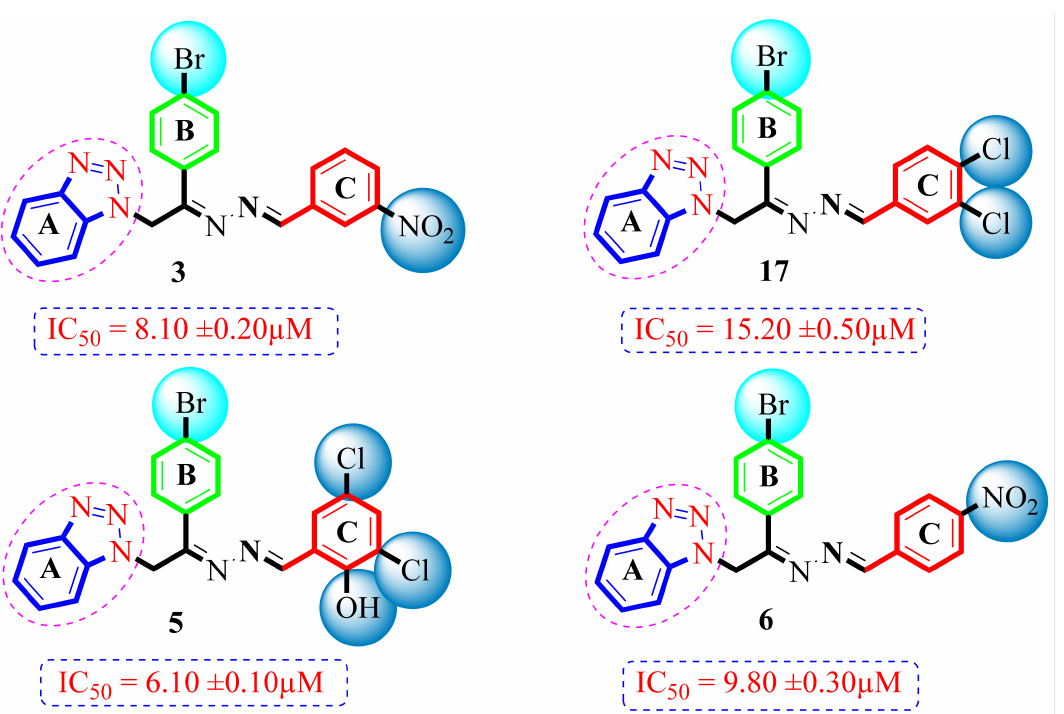
Figure 3. SAR study of compounds 3 , 5 , 6, and 17